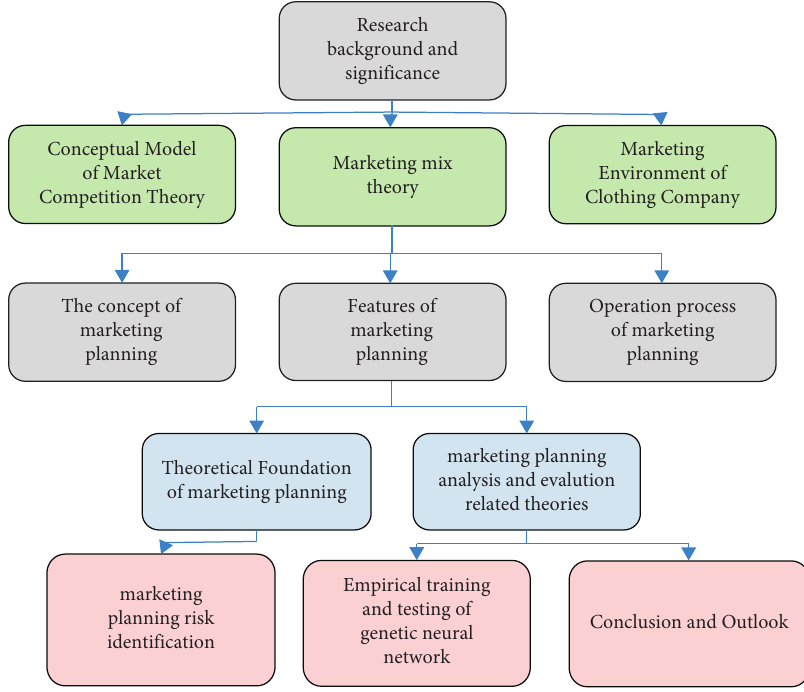
Figure 1: Marketing planning management flow